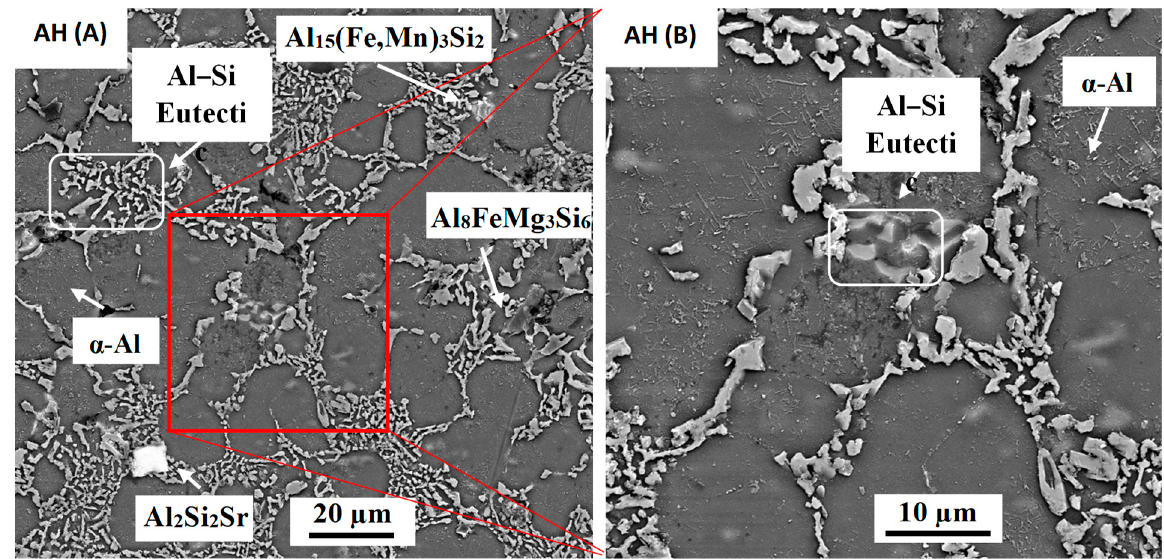
Figure 2. Representative micrographs for the as-cast component: ( A ) AH location; ( B ) close-up image of the red box region in ( A ) showing various phases.